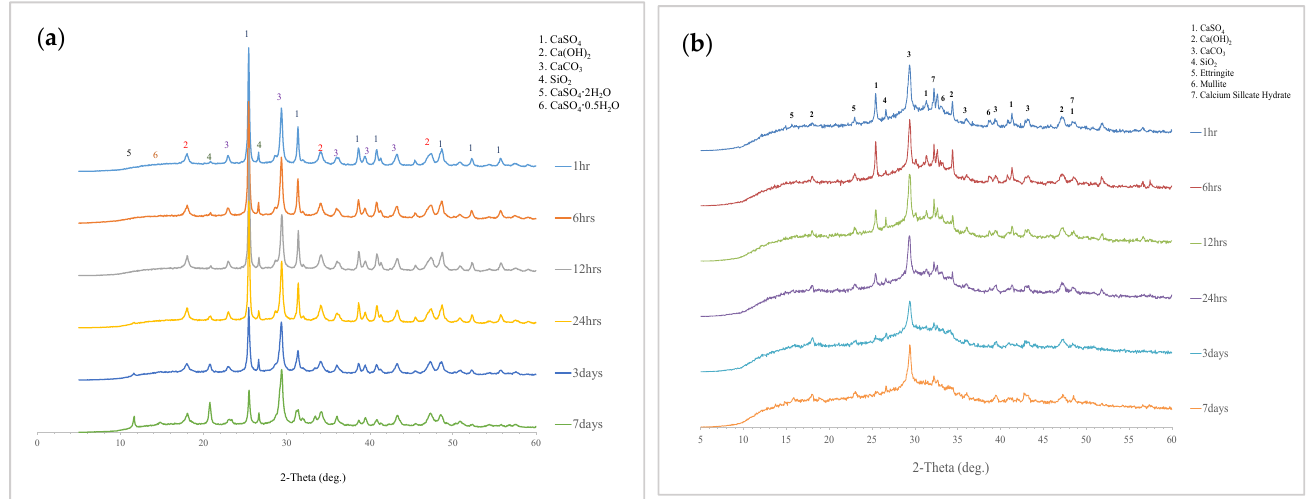
Figure 4. XRD pattern of Hydrated ( a ) CFB fly ash and ( b ) cement-CFB fly ash-BFS blended pastes from 1 h to 7 d of curing age.